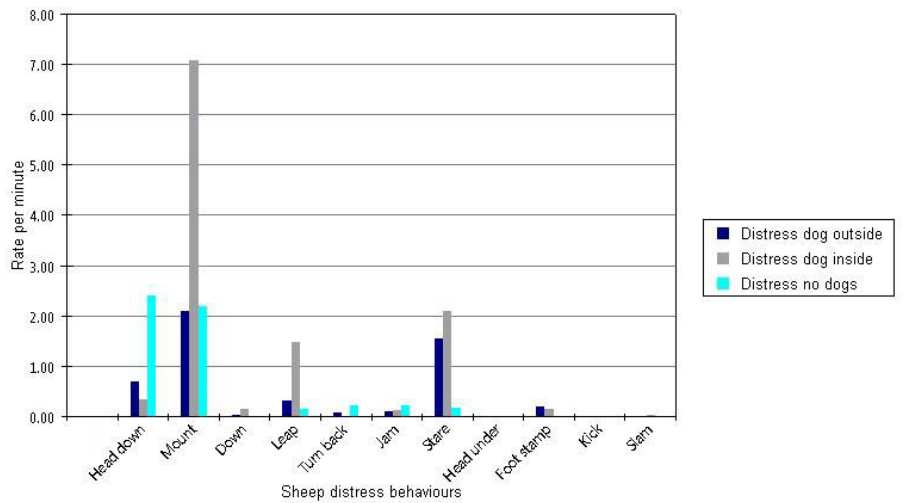
Figure 2. Untransformed rate of distress behaviours in sheep illustrating large fluctuations in commonality. Number of times the behaviour was recorded per minute across all video recordings analysed is shown on the Y -axis. Dark blue = when dogs present but outside flight zone; grey = dogs present and inside flight zone; light blue = dogs absent.